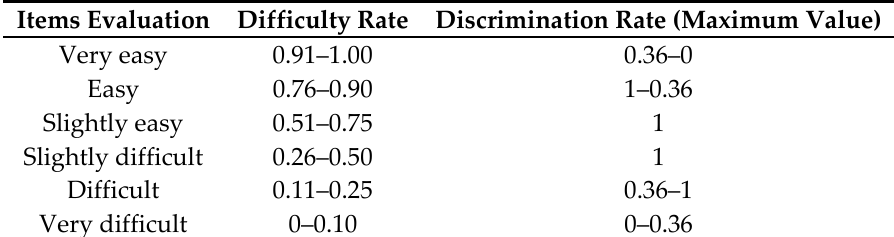
Table 2. Relation between the discriminating capacity of an item and its difficulty.